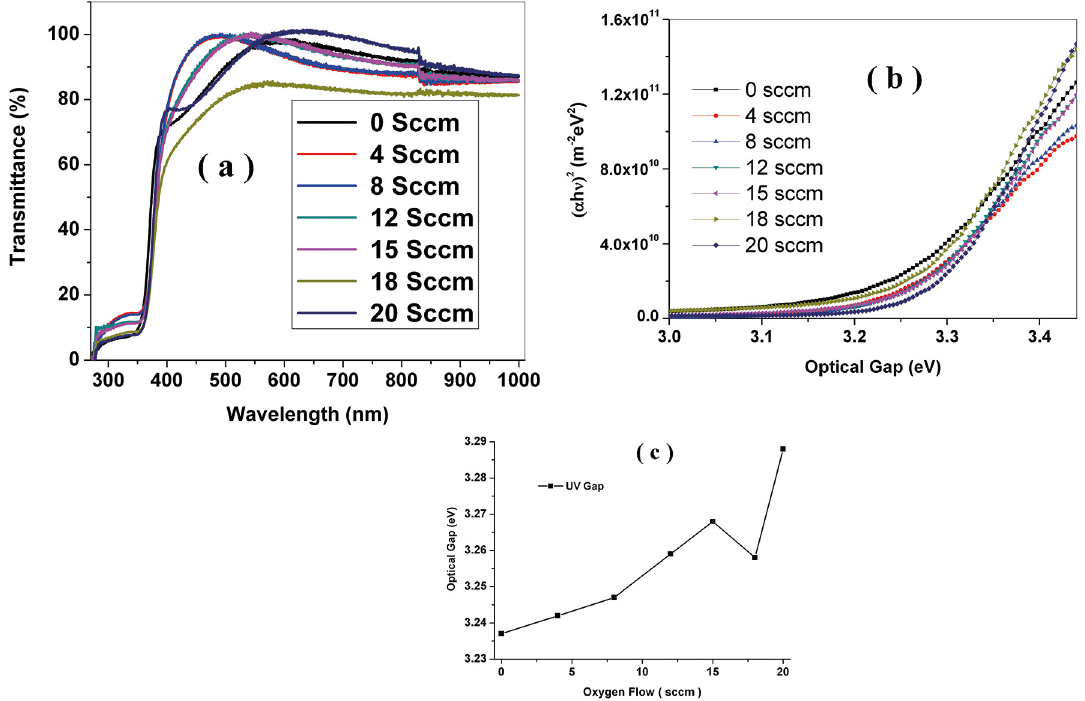
Figure 4: (a) Optical transmittance spectra for ZnO films on glass substrate, (b) the corresponding band gap and (c) optical gap with different oxygen flow.